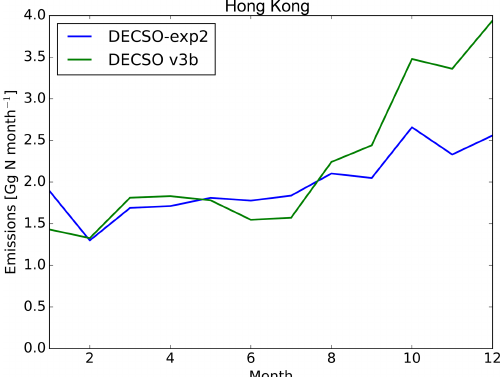
Figure 3. The total monthly NO x emissions over a remote ocean area [20 to 25 ◦ N, 125 to 130 ◦ E] derived with DECSO v3b, DECSO-exp, DECSO-exp2 and DECSO v4.